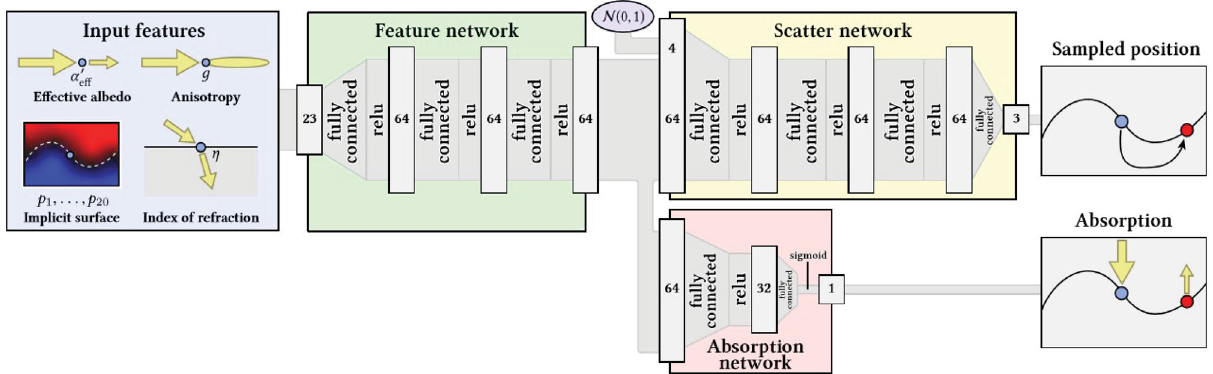
Fig. 20 Network structure of the shape-adaptive BSSRDF model. Reproduced with permission from Ref. [66], c (cid:2) ACM 2019.